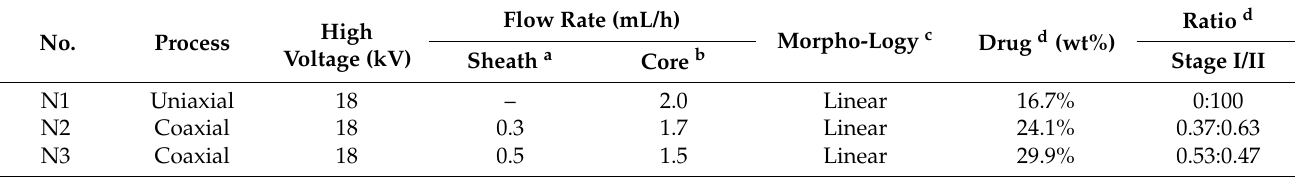
Table 1. Parameters for preparing the hybrid medicated